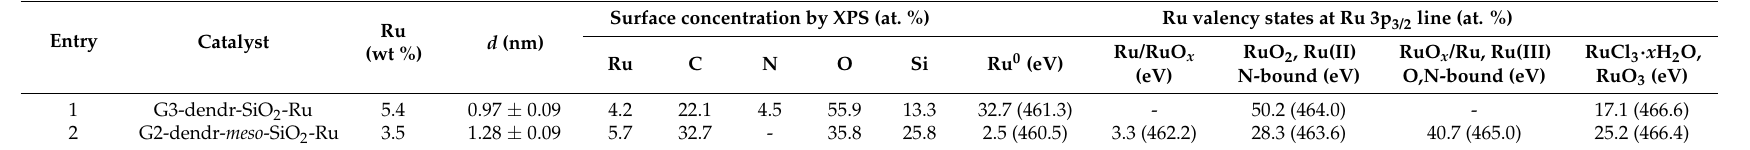
Table 1. Physical and chemical properties of the catalysts